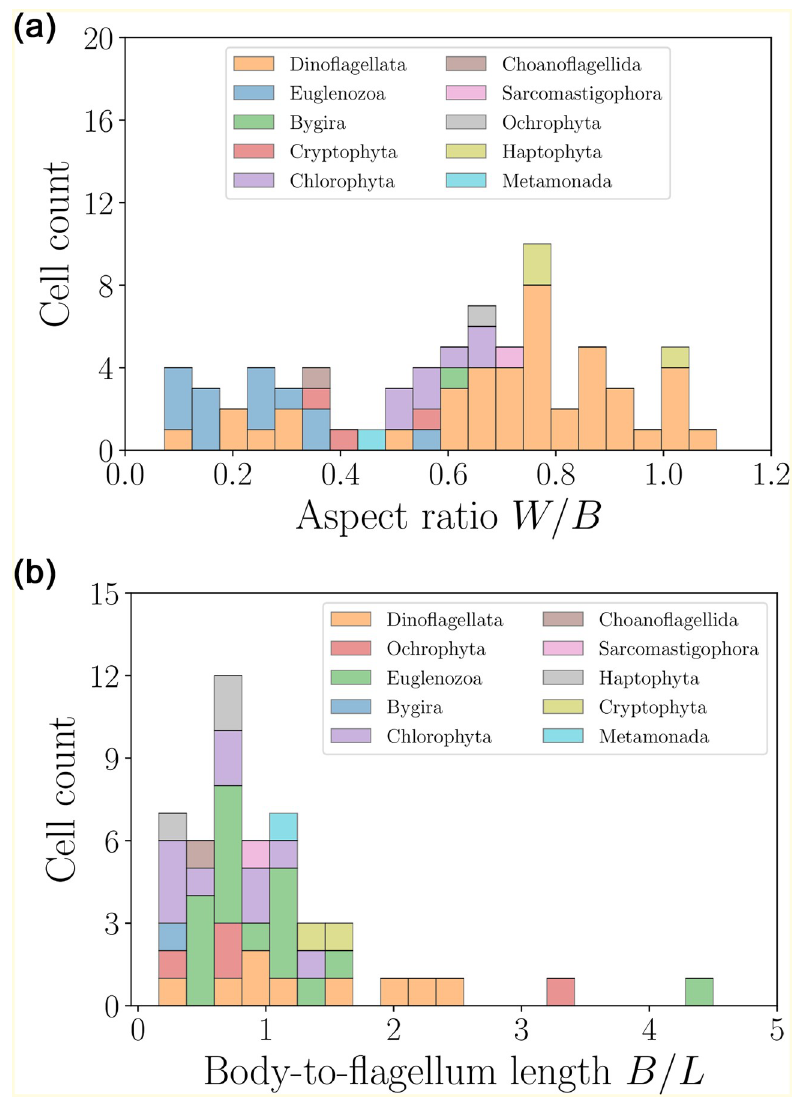
Fig 9. Histograms of aspect ratios W / B (left) and body-to-flagellum length ratios B / L (right) for flagellated eukaryotic swimmers. For all organisms in this category, the aspect ratios do not exceed � 1.1, and the shape distribution indicates a slightly prolate shape on average, with h W / B i = 0.60 ± 0.27 ( n = 73). The distribution of body- to-flagellum length ratios shows that flagella tend to be of length comparable to the cell body, with a few exceptions h B / L i = 1.03 ± 0.79 ( n =